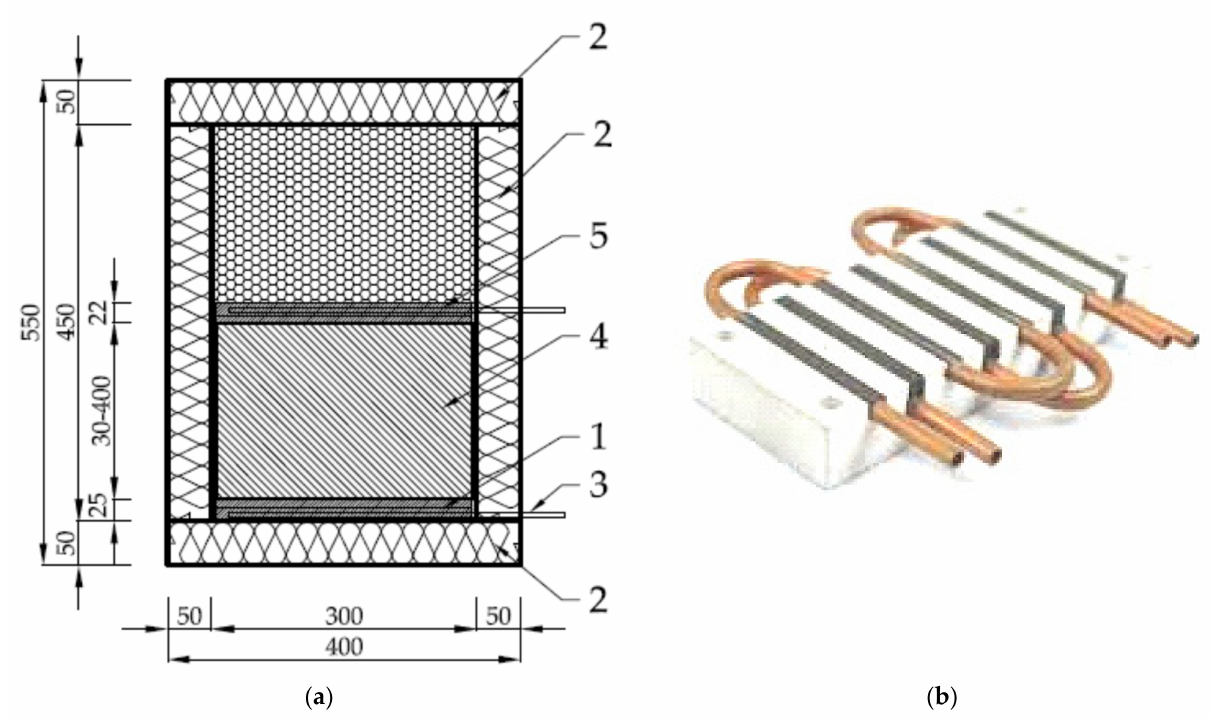
Figure 5. Main dimensions in millimeters of the calorimeter ( a ): 1—cooling and low temperature measurement plates, 2—thermal and moisture insulation, 3—cooling coils, 4—sample material, 5—heating and high temperature measurement plates. Photo illustrates the cooling coils arrangement method ( b